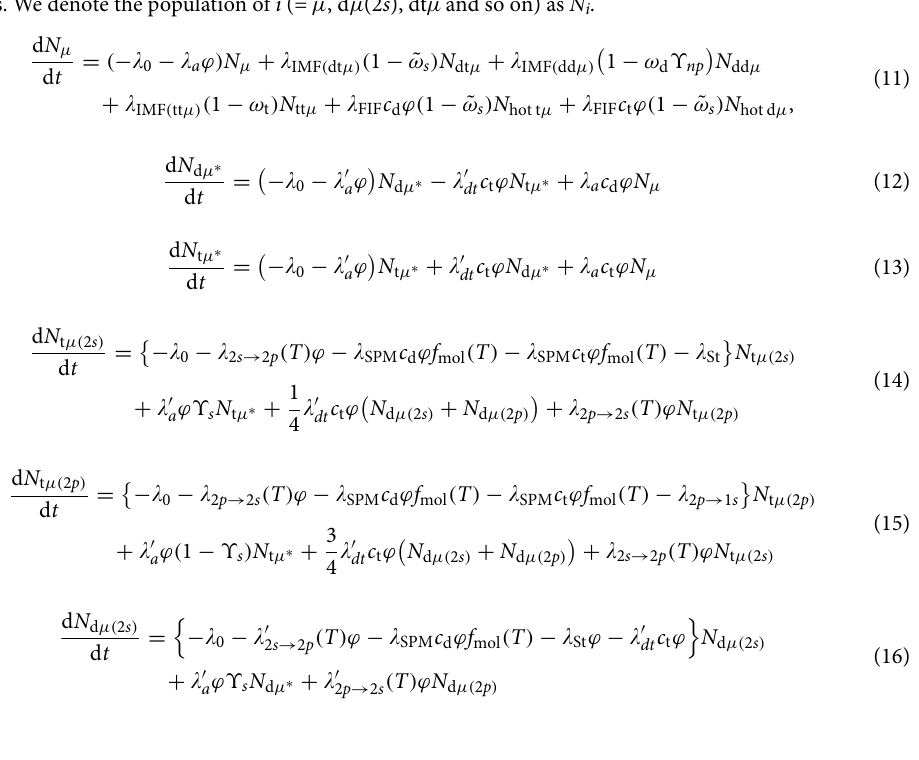
3 ). The white 3 ; 1